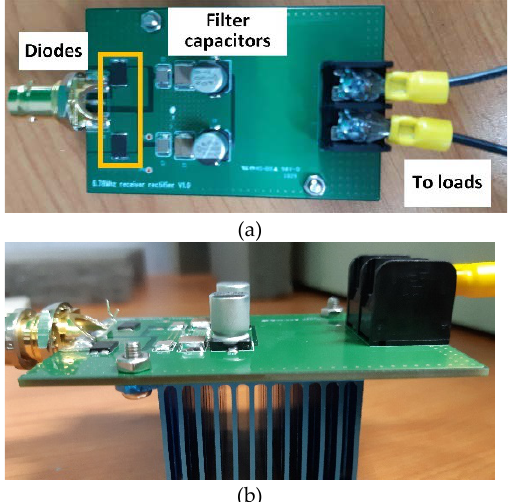
Figure 13. A photo of the assembled H-bridge inverter.